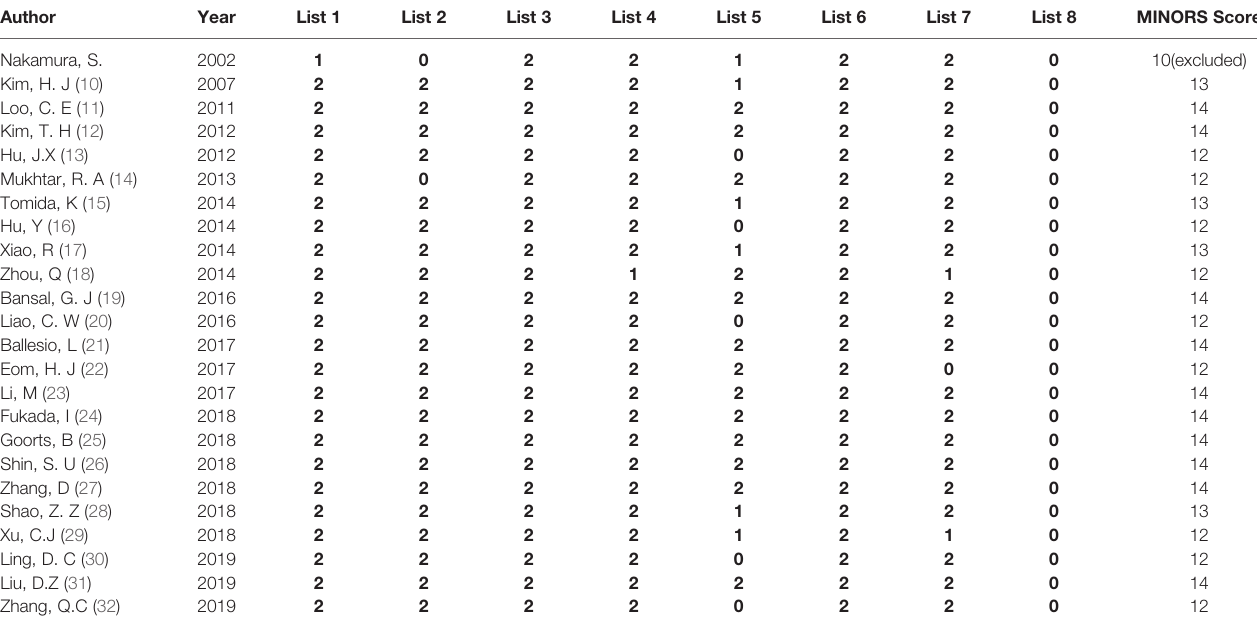
TABLE 1 | Univariable analysis and multivariable analysis of the model and clinical features.